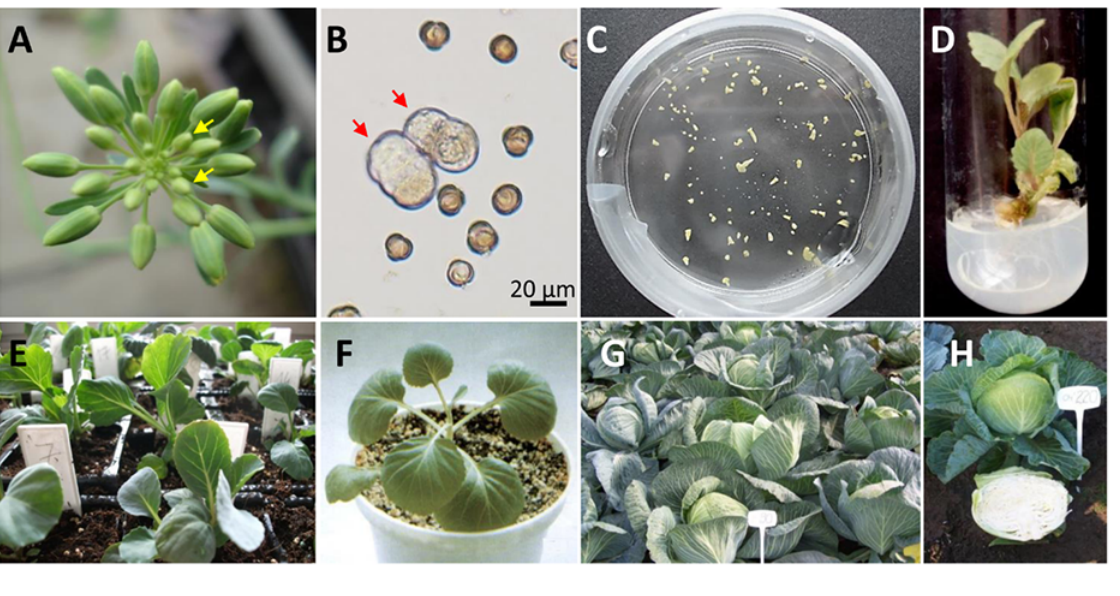
Figure 10 Androgenesis in microspore culture of Brassica oleracea var. capitata L. ( A ) Inflorescence of cabbage, buds suitable for androgenesis marked with an arrow. ( B ) First mitosis in isolated microspore culture marked with arrows. ( C ) Androgenic embryos. ( D ) Regenerated plantlet. ( E,F ) DH plants aer acclimatization. ( G,H ) DH lines in the field experiment.